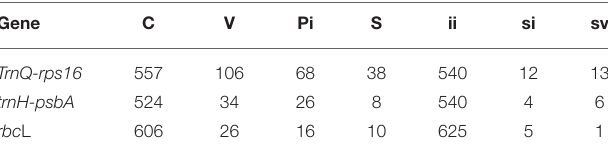
TABLE 3 | Features of the matched data matrix for trnQ-rps16, trnH-psbA, and rbc L gene